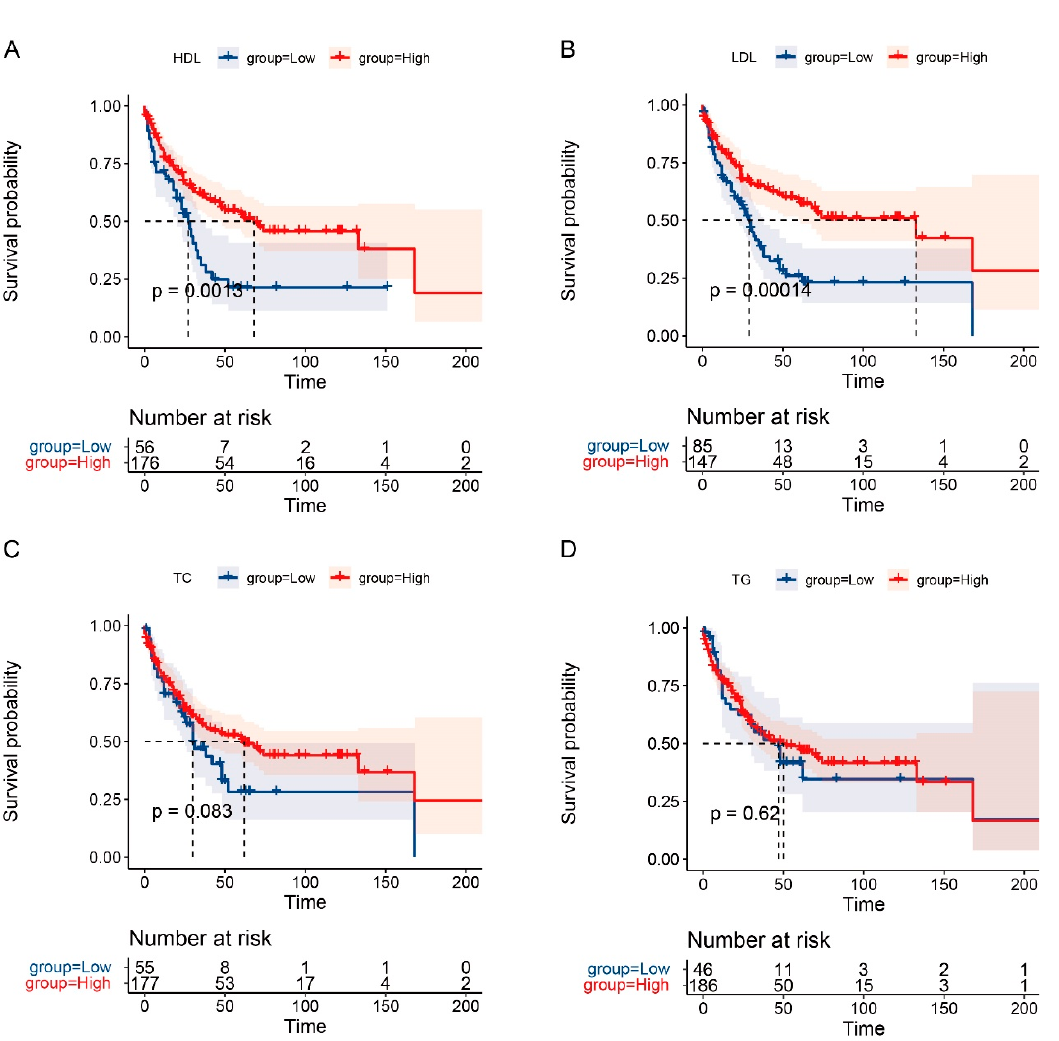
Figure 3. Survival analysis of RFS for AC patients. KM curves of RFS for HDL ( A ), LDL ( B ), TC ( C ), and TG ( D ). Table 5. Univariate and multivariate analysis of ampullary adenocarcinoma with RFS. Univariate Analysis Multivariate Analysis Variate